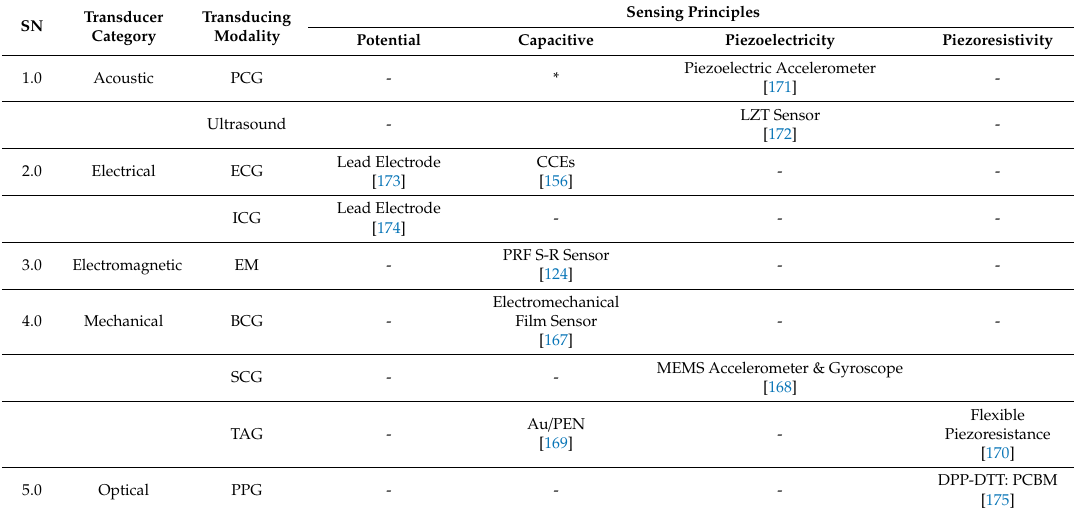
Figure 5. Transducing modalities used in blood pressure measurement. Table 2. List of transducing modalities with some of their associated sensing